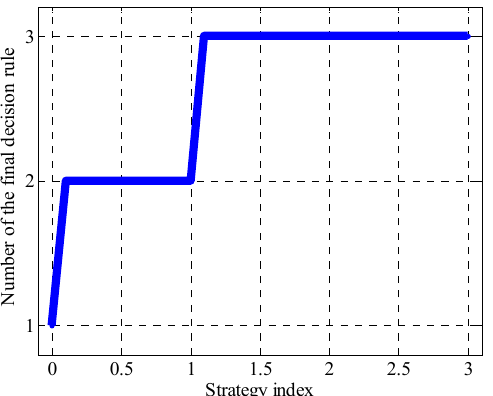
Figure 6. Dependence of the number of the final GDRC on the assessment strategy.